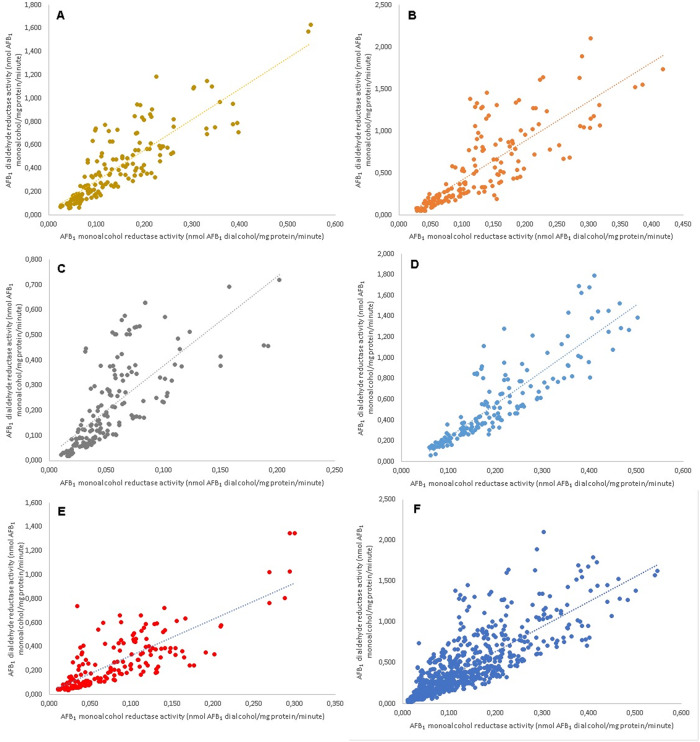
Correlation of AFB1 monoalcohol reductase enzyme activity vs AFB1 dialdehyde reductase enzyme activity velocities.Cytosolic fractions from 12 birds were used and concentrations of AFB1 dialdehyde from 3.6 to 66.4 μM. Spearman’s rank-order correlation coefficient was calculated for A: Ross chicken breed (0.87), B: Rhode Island Red Chicken breed (0.88), C: quail (0.84), D: turkey (0.91), E: duck (0.78) and F: all species (0.86).